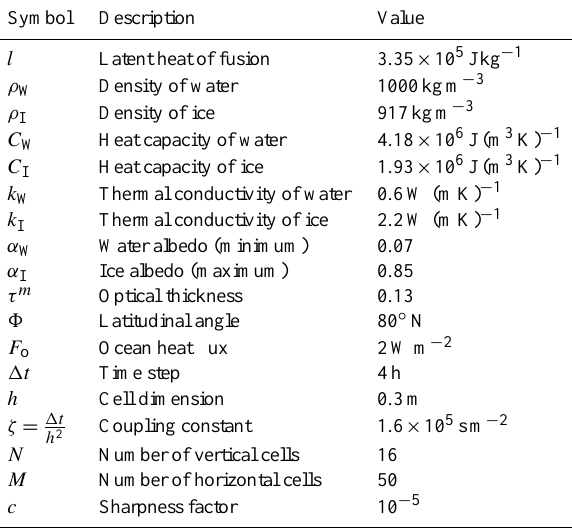
Table 1. Physical constants and system parameters used in all sim- ulations unless stated